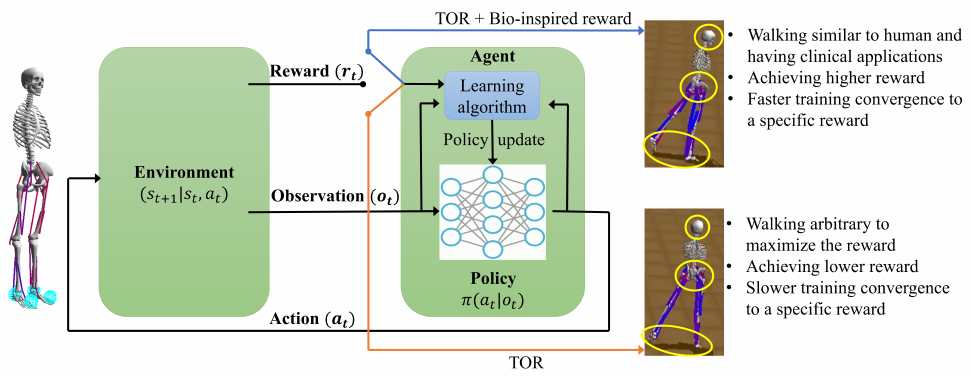
Figure 3. Reinforcement learning algorithm with the reward function consisting of trajectory op- timization reward and bio-inspired reward. Employing IMU constraints in the reward function enhances the musculoskeletal simulation with RL by making the locomotion similar to human walk- ing. The circled regions with yellow show the head, pelvis, and legs’ directions during waking. When IMU data is used in training, the gaits are straight and similar to the human. In contrast, when no IMU data is used in training, the agent walks inefficiently, which is not similar to real human